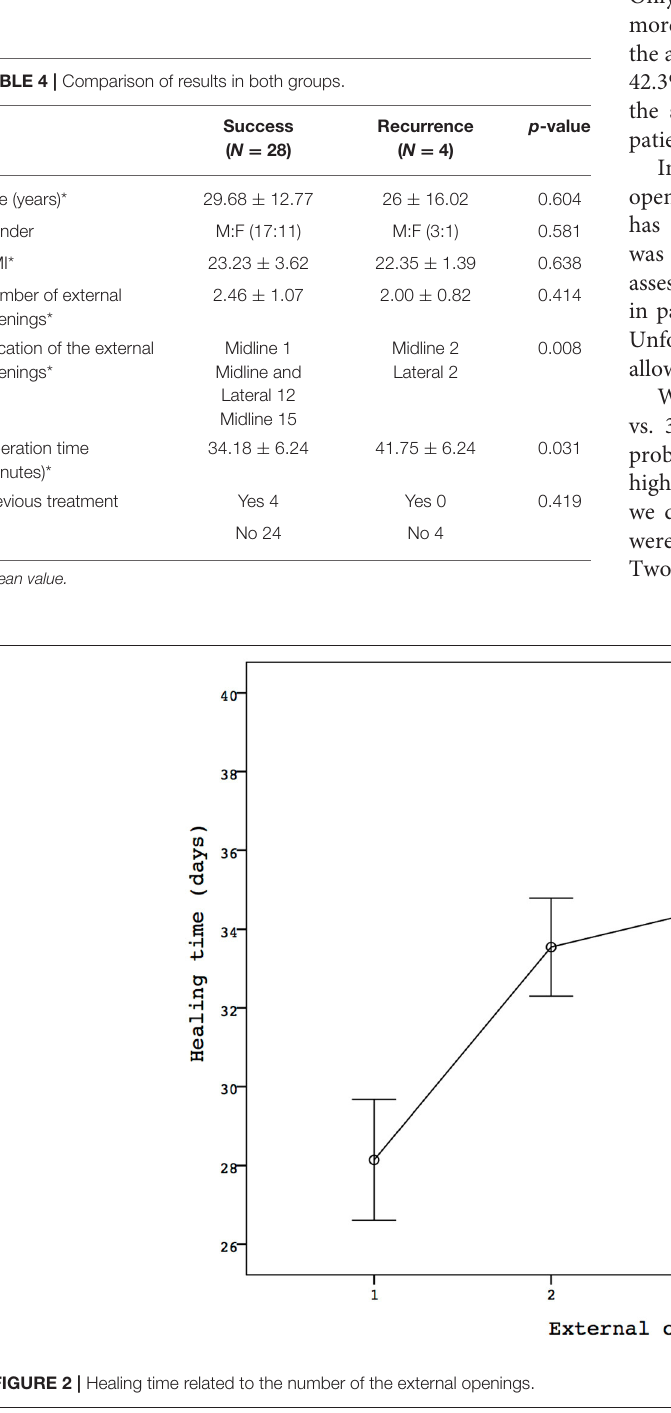
Frontiers in Surgery |